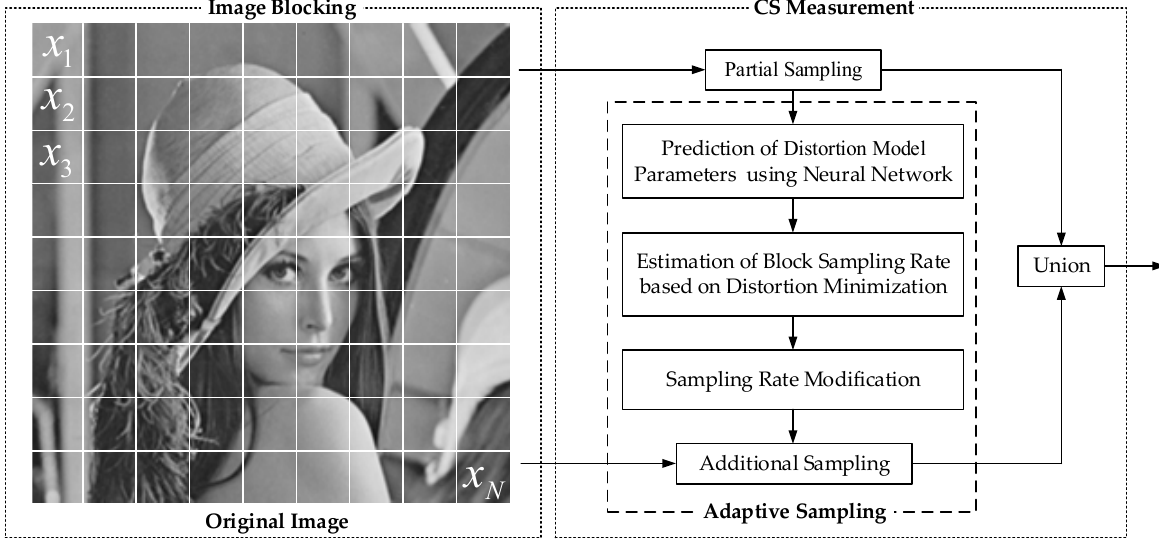
Figure 1. The proposed ABCS scheme.